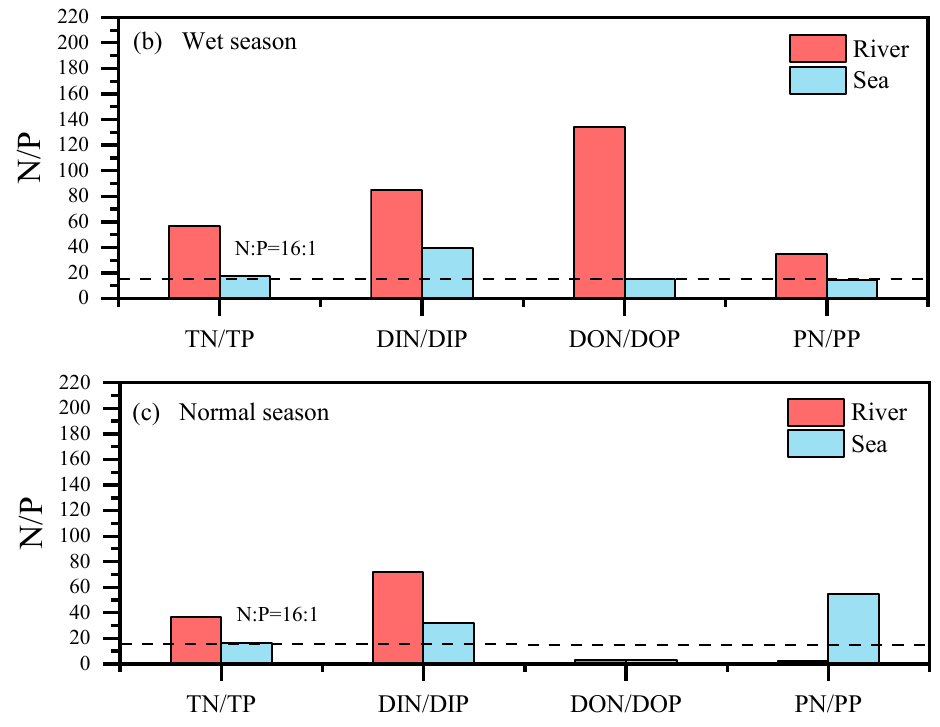
Figure 5. Seasonal variation in N/P in estuaries and seawater of the Maowei Sea.